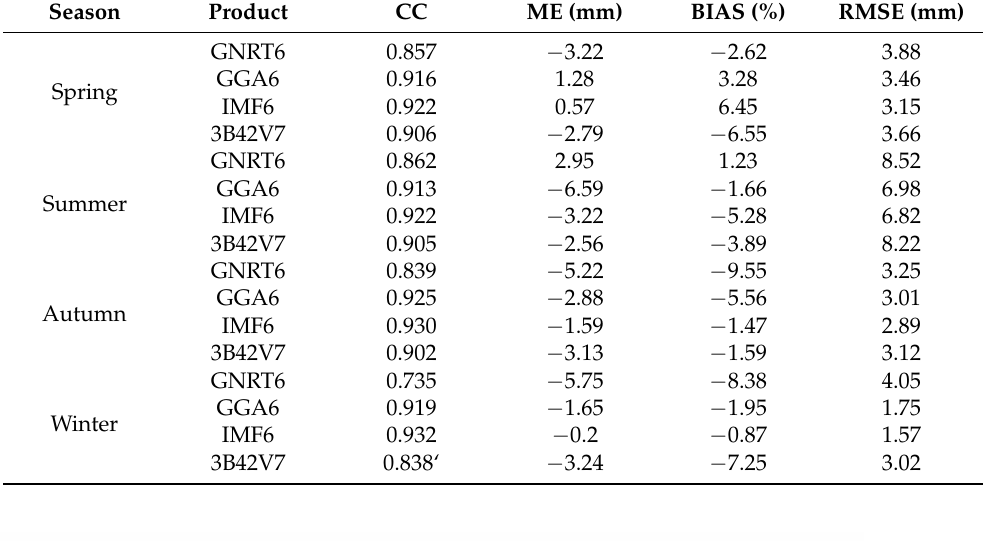
Table 4. Seasonal statistics of the four SREs w.r.t in situ observations over Mainland China.